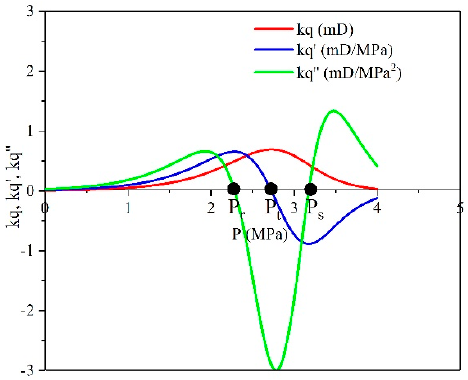
Figure 2. The dynamic curve of permeability curvature and its first and second derivatives in the single-phase water flow stage.